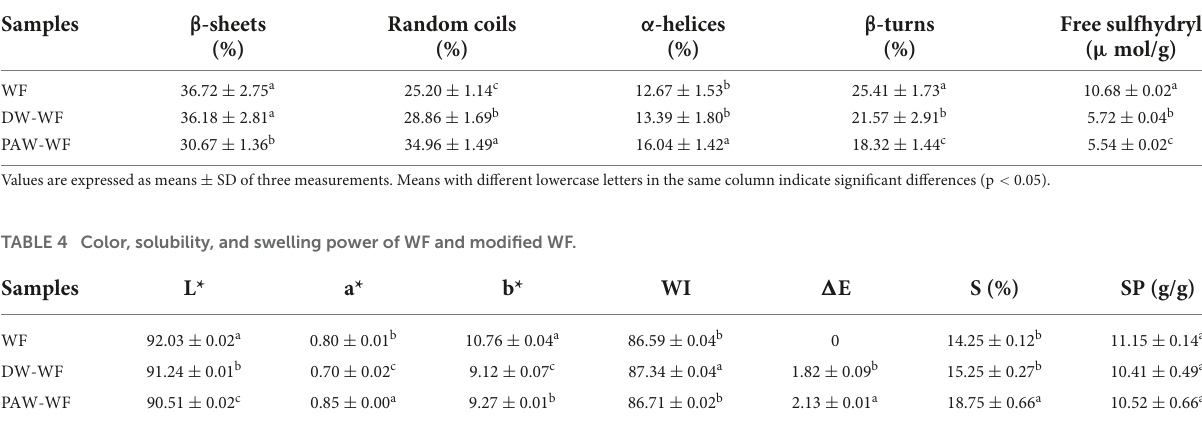
TABLE 3 Secondary structure and free sulfhydryl content of protein in WF and modified